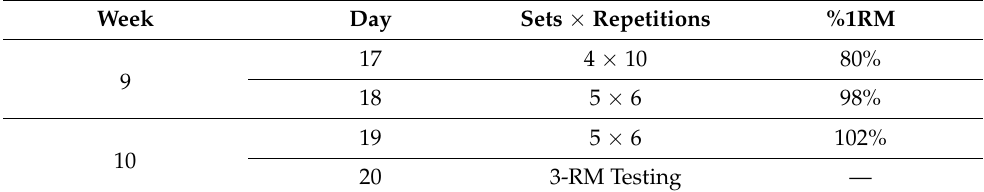
Legend: This table represents the training paradigm for the 10-week progressive resistance training program. Abbreviations: 3-RM, three-repetition maximum test. For males, 12 participants ( n = 4 PP, n = 8 CTL) provided viable 3-day food logs for both T1 and T3 (Table 4). With the inclusion of the PP supplement, there was no significant interactions for daily energy ( p = 0.391), carbohydrate ( p = 0.209), fat ( p = 0.800), or protein intakes ( p = 0.775).